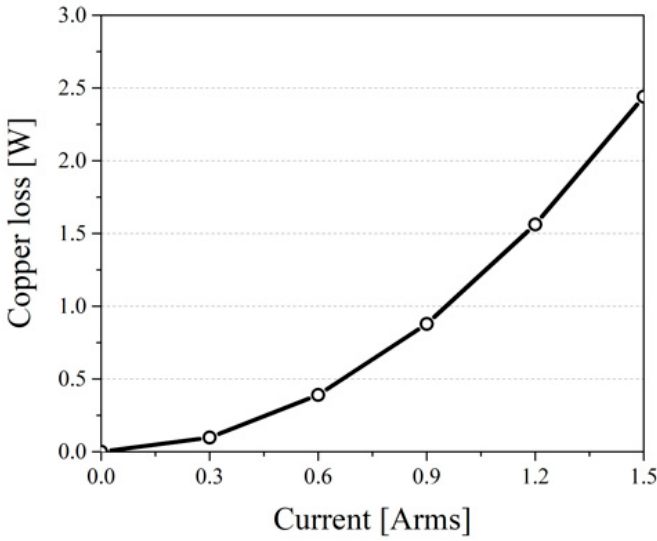
Figure 5. Copper loss analysis result according to applied current.